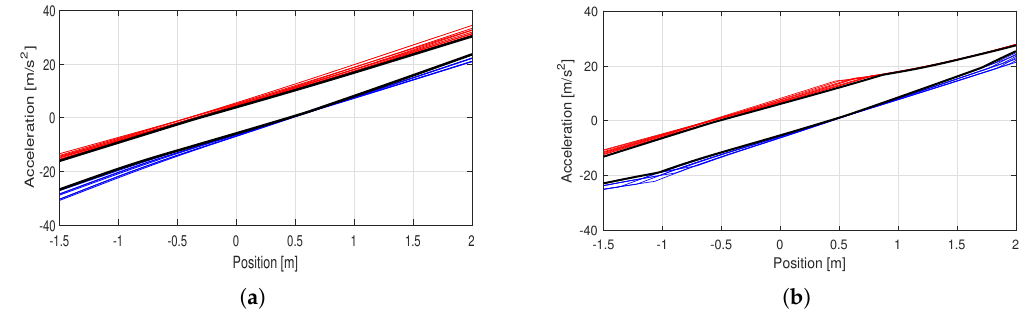
Figure 7. Comparison between the maximum acceleration limits (red) and minimum ones (blue) along a line d towards the SP obtained without considering the actuator dynamics ( a ) and considering the actuator dynamics ( b